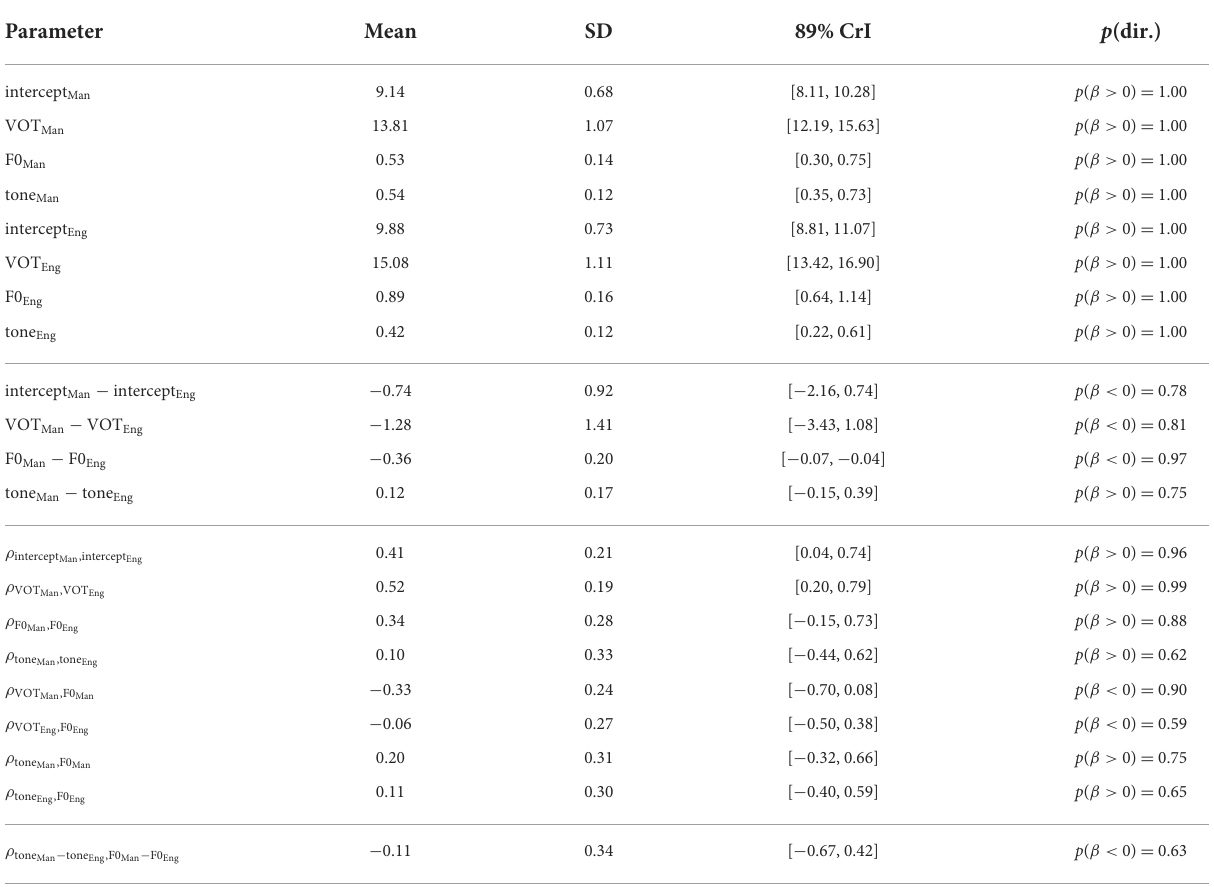
TABLE 5 Marginal posterior summary for key population-level parameters from M4.